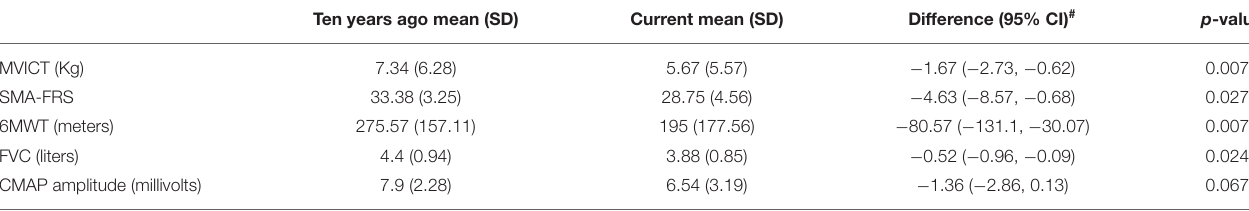
TABLE 3 | Ten-year change of outcome measures from eight participants in the prior VALIANT